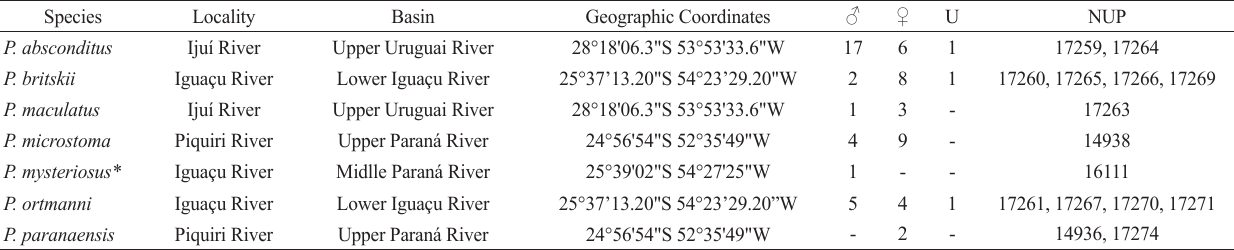
Tab. 2. Sample data of analyzed Pimelodus . *Population downstream from the Iguaçu Falls. ♂ = male, ♀ = female, U = Unidentified, NUP = voucher numbers of the Coleção Ictiológica do Nupélia.